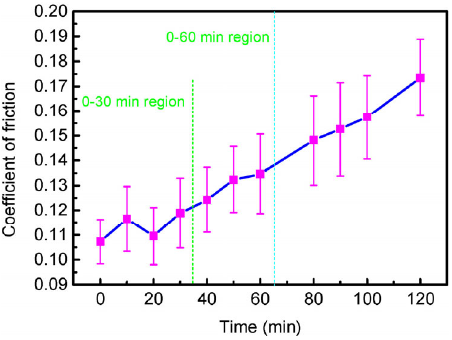
Fig. 8 The dependence of BP friction on air exposure time, under 119 nN normal load (Setpoint=1 V).